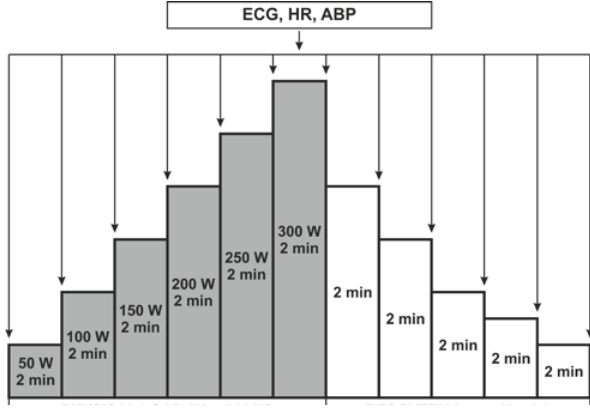
Figure 1: Protocol scheme of recording cardiovascular functional